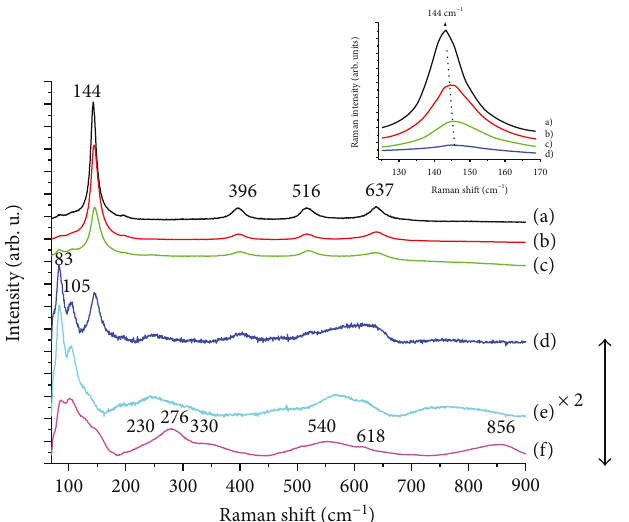
Figure 2: Raman spectra of the TiO thin fi lms modi fi ed with several bismuth contents of (a) 0, (b) 0.5, (c) 4.9, (d) 10.4, (e) 21.5, and (f) 2 25.4at. %.